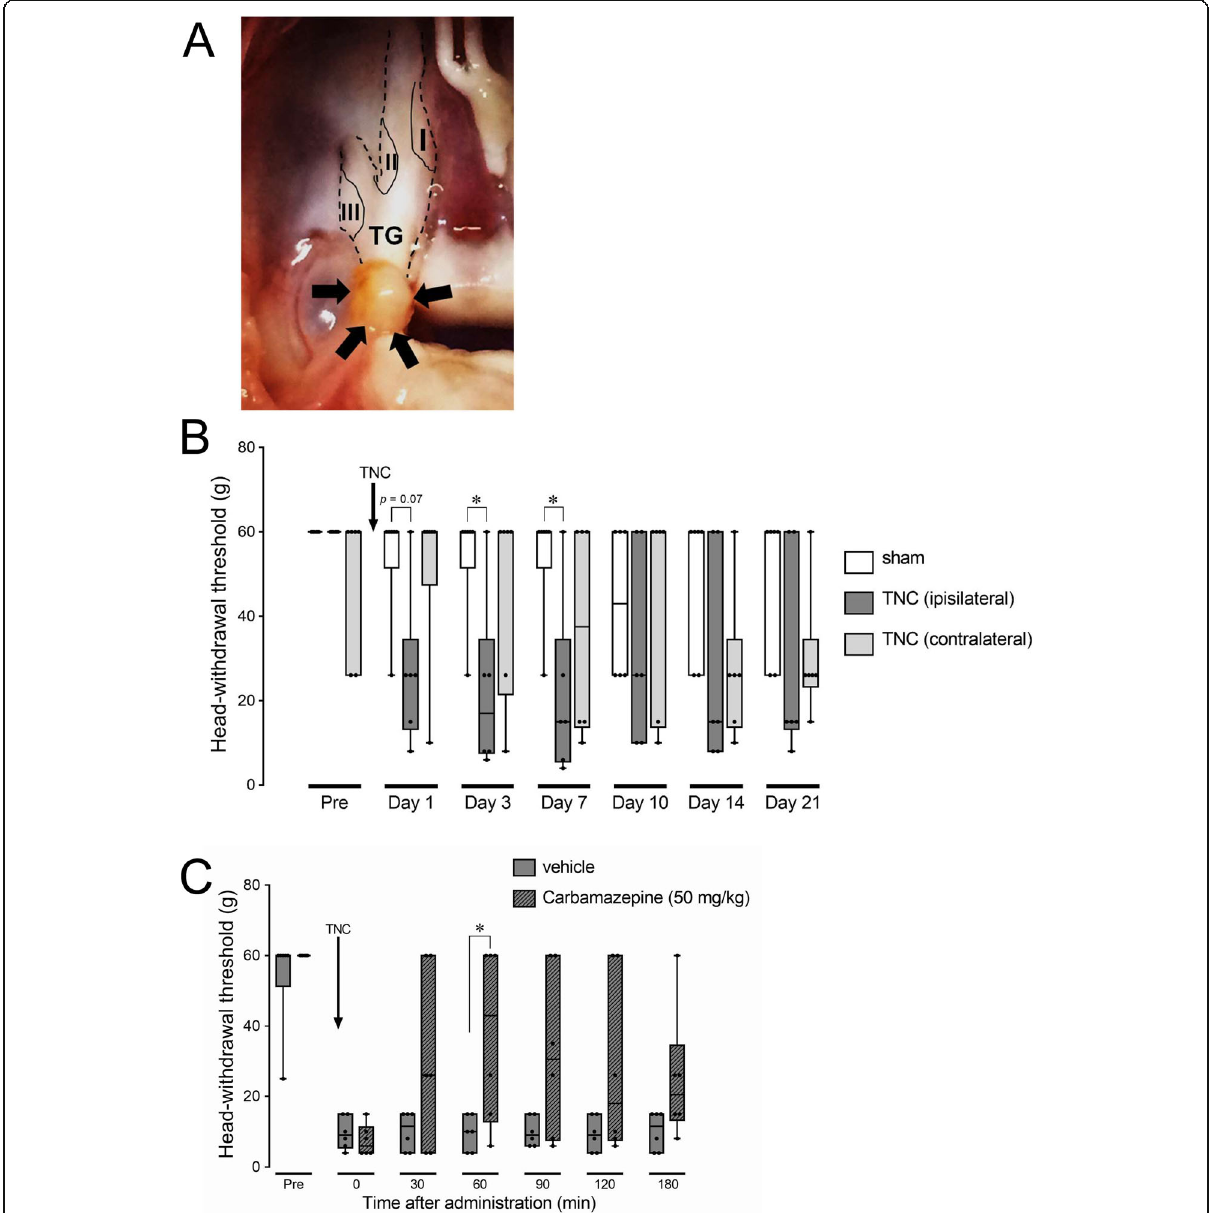
Fig. 1 Orofacial mechanical hypersensitivity following TNC and its inhibition by carbamazepine. a The trigeminal root following TNC. Arrows indicate the depressed region. I, II, and III indicate the location of neuronal soma innervating to the ophthalmic division, maxillary division, and the mandibular division, respectively. b The alteration of whisker pad skin MHWT bilateral to the TNC or sham procedure for 21 days. Data are presented as median, interquartile range (25 – 75 %), and maximum and minimum values. * p < 0.05 vs. sham. ( n = 6 in each; Kruskal-Wallis followed by Dunn ’ s multiple comparisons test). c The suppressive effect of i.p carbamazepine administration on orofacial mechanical hypersensitivity on day 7 following TNC. Data are presented as median, interquartile range (25 – 75 %), and maximum and minimum values. * p < 0.05 vs. vehicle. ( n = 6 in each; Kruskal-Wallis followed by Dunn ’ s multiple comparisons